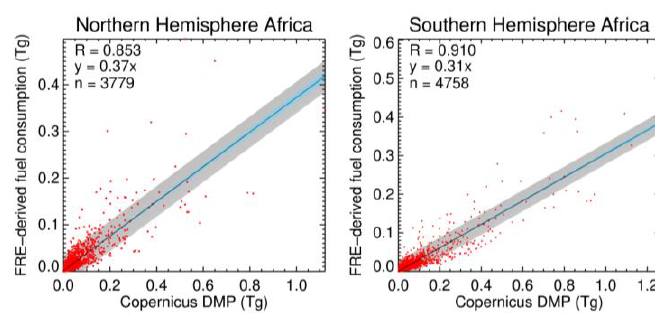
Figure 7. Relationship between FRE-derived fuel consumption (Tg DM) and accumulated Copernicus dry matter productivity (DMP, Tg DM) for fire clusters that burned between 2013 and 2016 in northern and southern hemisphere Africa. The grey shaded area represents the prediction interval and the blue shaded area is the slopes 95% confidence interval. Note that the x - and y -axis range differs among plots. Fuel Consumption Per Unit Area (m − 2